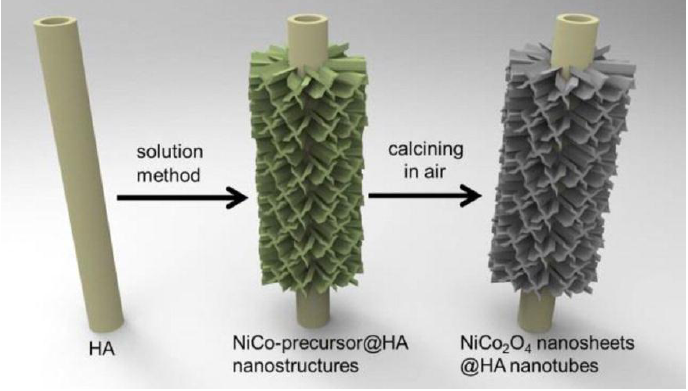
Figure 11. Schematic of the synthetic procedure of NiCo 2 O 4 nanosheets@halloysite nanotube hybrid nanostructures. With permission from [84]; Copyright 2012, American Chemical